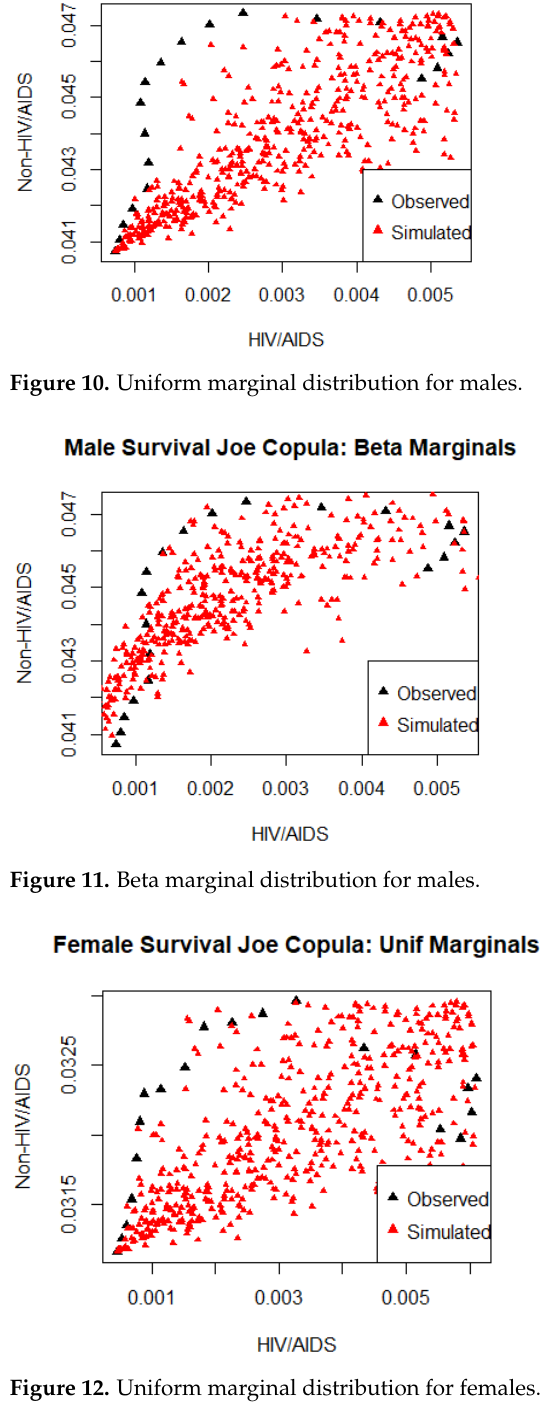
Figure 13. Beta marginal distribution for females.